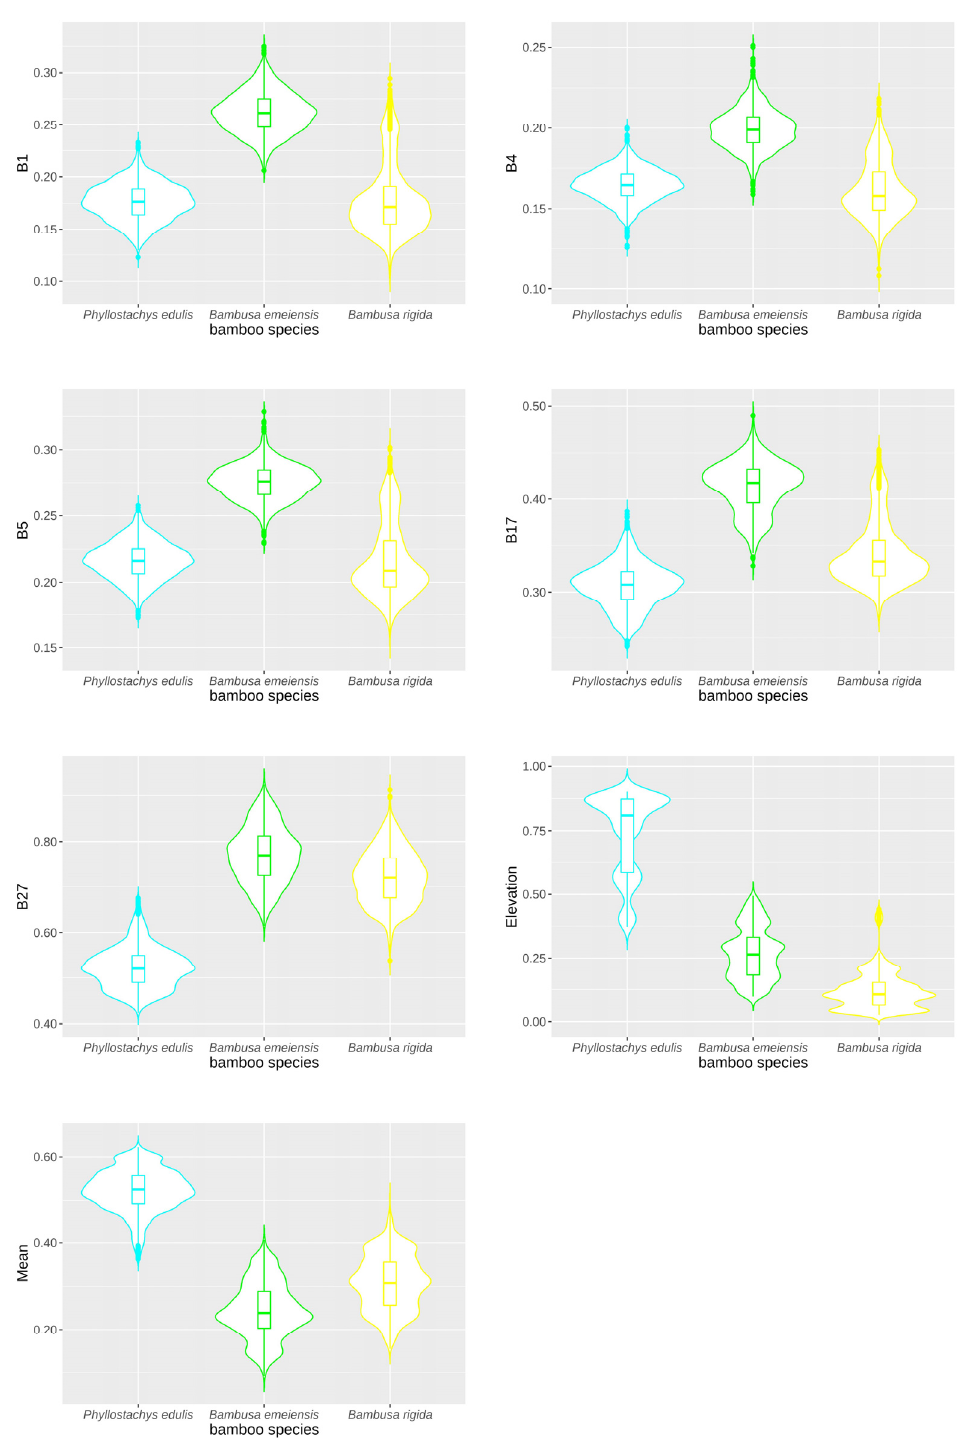
Figure 13. The distribution of values by bamboo species for the important and uncorrelated varia- Note: All feature variables are normalized to bles. Note: All feature variables are normalized to 0–1.